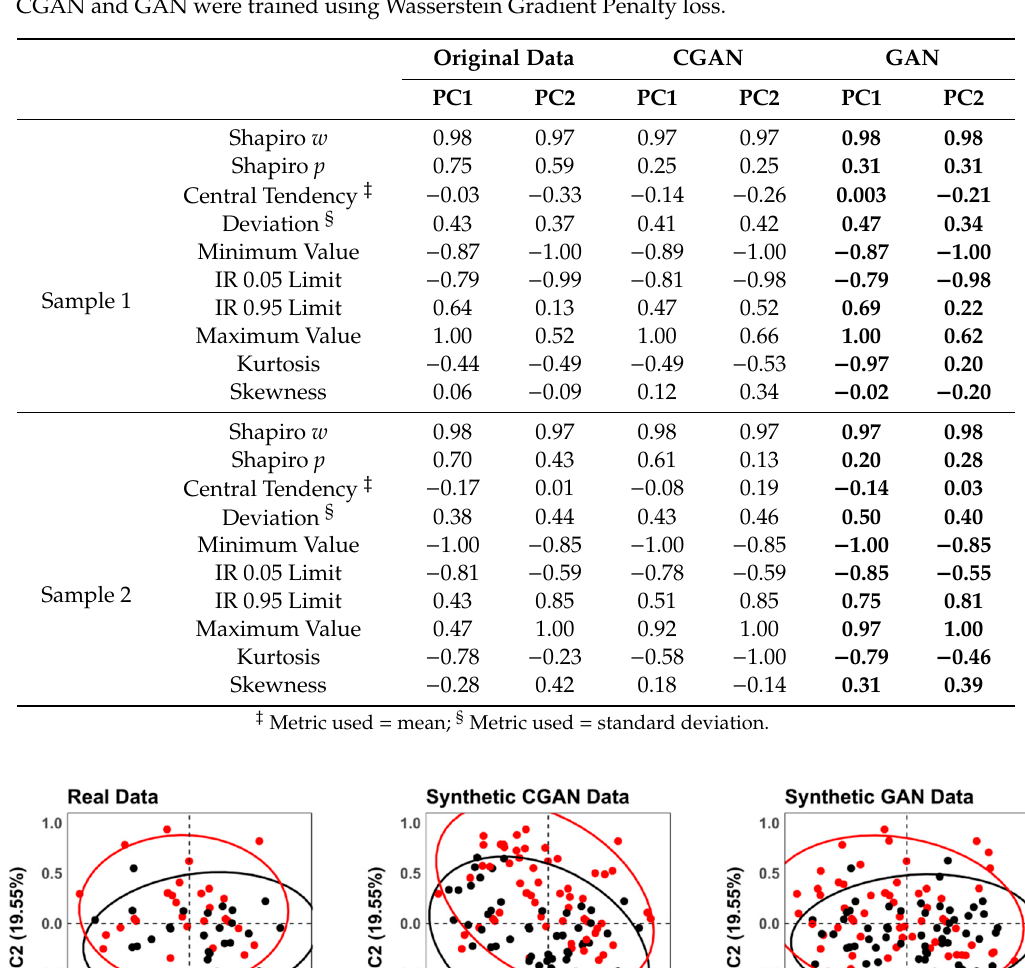
Table 9. Descriptive statistics for augmented DS3 targeting label values specifically. Numbers marked in bold indicate the synthetic data that obtained the most significant rTOST equivalency p -values. Both CGAN and GAN were trained using Wasserstein Gradient Penalty loss.